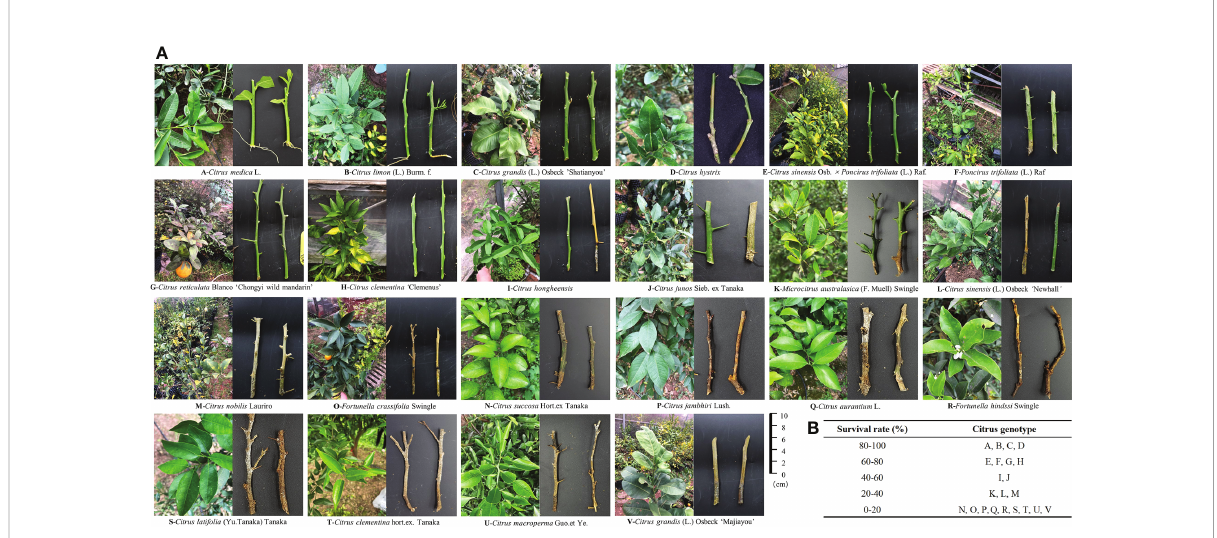
FIGURE 1 Comparative analysis of percentage explant survival of citrus accessions in vermiculite. (A) Citrus explants were incubated in vermiculite [28°C, 16 h/8 h (light/dark), and 90% relative humidity] after vacuum in fi ltration. Statistical analysis was performed on the survival data for explants at 15, 30 and 45 days post-in fi ltration (dpi), respectively. (B) Statistical analysis of explant